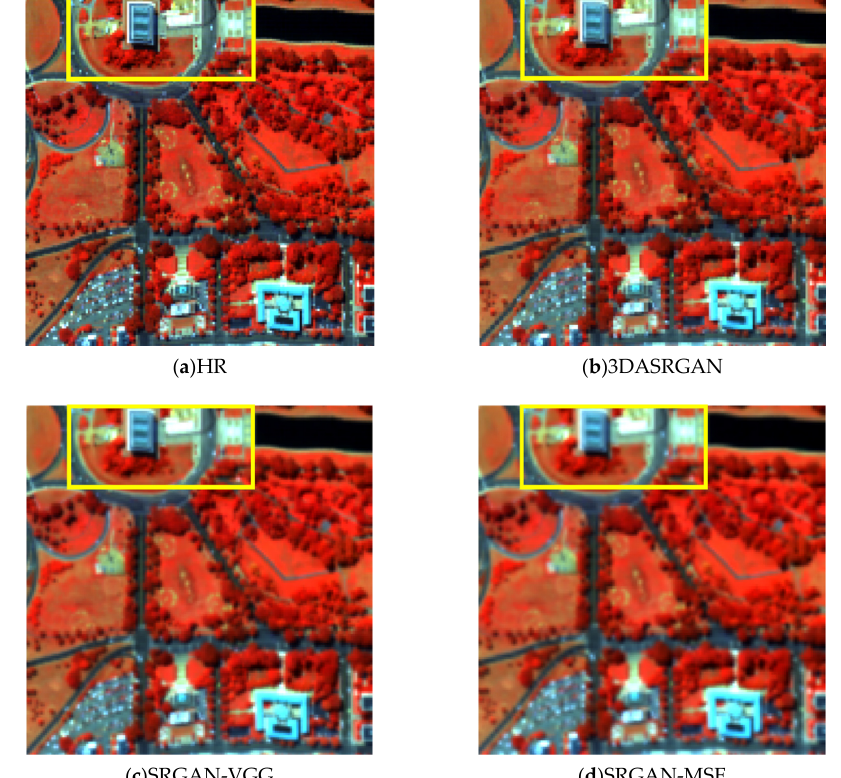
Figure 15. Results of the HR image, 3DASRGAN, SRGAN-VGG, and SRGAN-MSE based on the Washington DC Mall dataset.